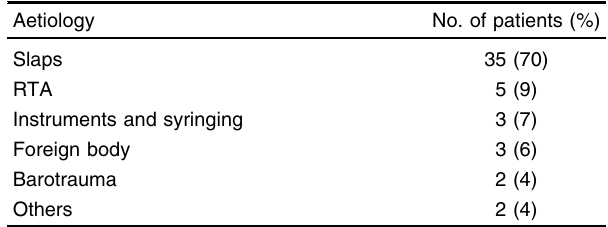
Table 2 Aetiological profile of patients with tympanic membrane perforation